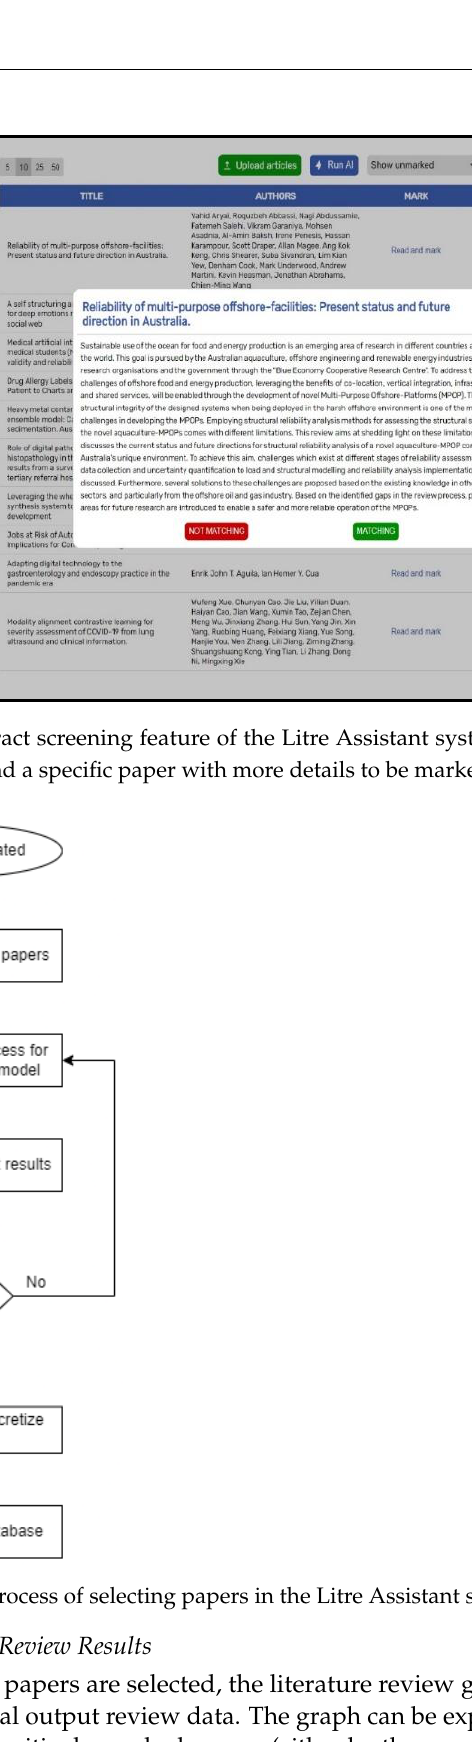
Figure 9. Results feature of the Litre Assistant system showing complete literature results, including the chart and data export features.